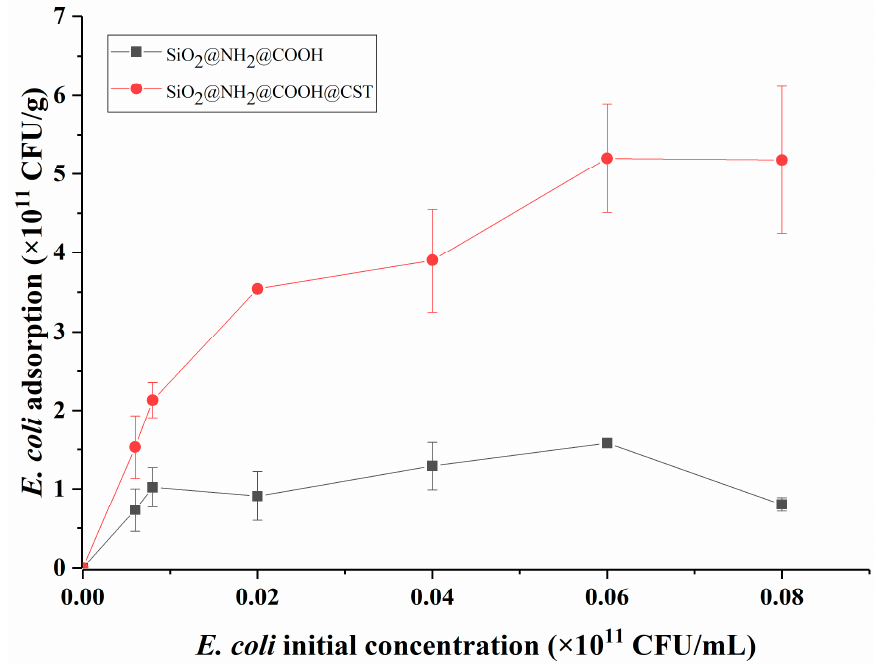
Figure 4. Adsorption isotherms of SiO 2 @NH 2 @COOH and SiO 2 @NH 2 @COOH@CST.